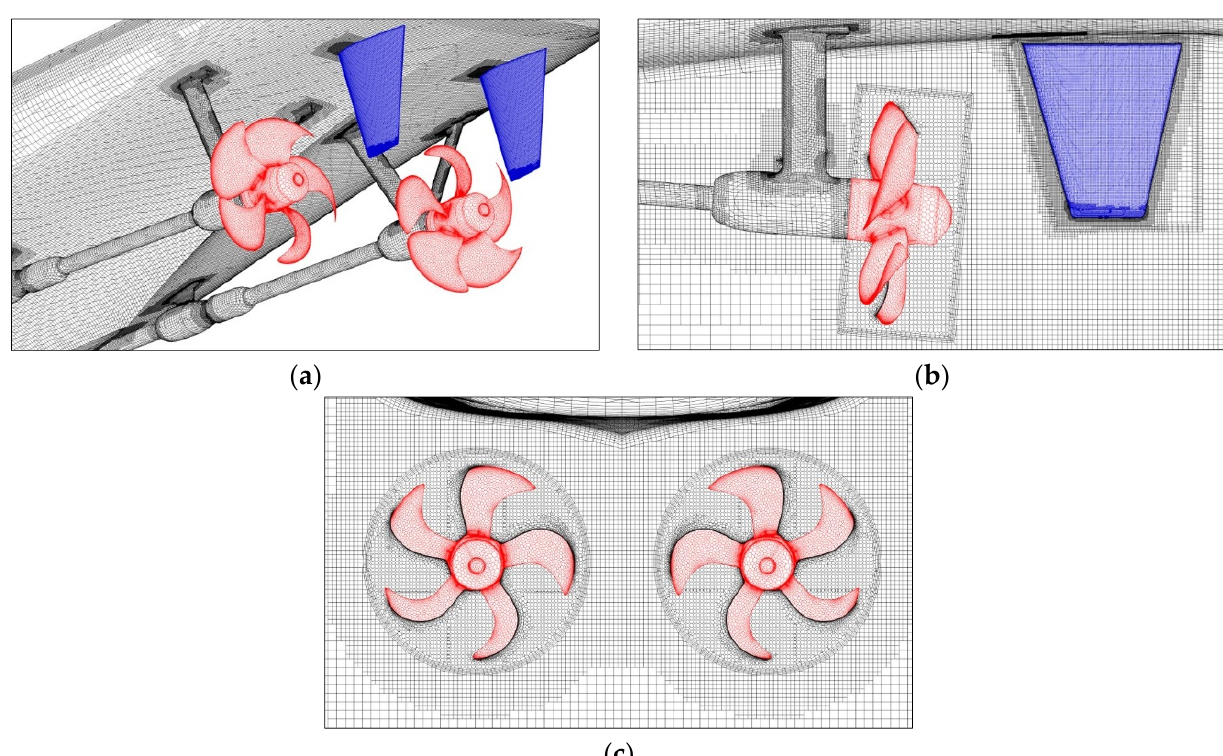
Figure 3. Computational surface and field grid distributions around the hull, propeller, and rudder: ( a ) grid distribution on the full appended hull surface; ( b ) field grids on the longitudinal plane passing through the center of the port rudder; ( c ) field grids on the transverse plane passing through the center of the propeller.